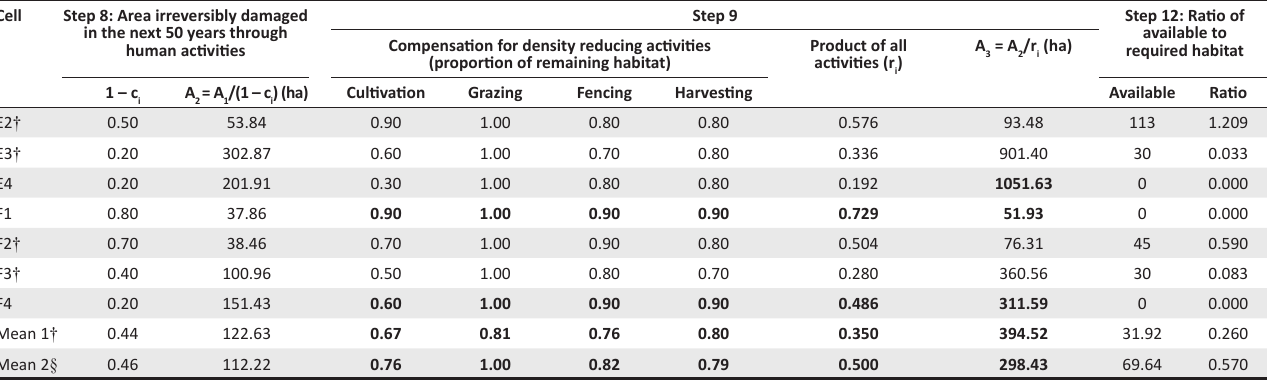
TABLE 2c (Continues...): Brackenridgea zanguebarica minimum conservation area size using Burgman et al. ’s method (Steps 8, 9 and 12): Scenario 2 – No grazing. Cell Step 8: Area irreversibly damaged in the next 50 years